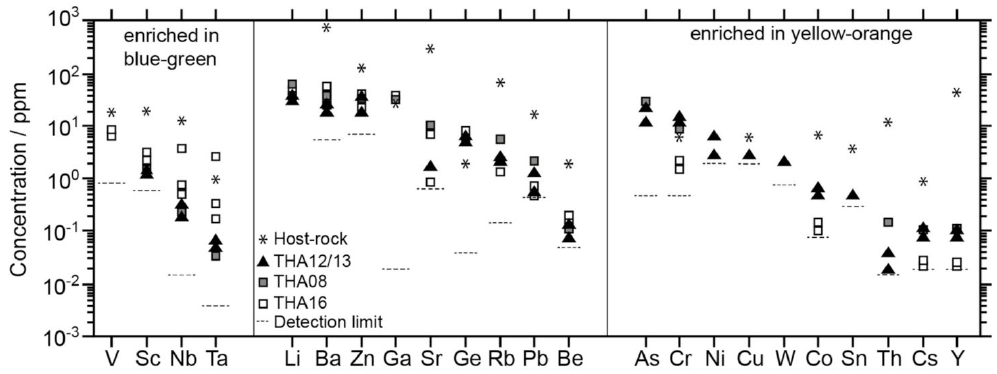
Figure 10. Trace element composition of host-rock CS16_292b and kyanite samples ordered by decreasing concentration. The left part shows elements which are preferentially found in blue-green THA16 kyanite samples, the central part where there is no significant di ff erence among the samples and the right part reports the elements with significant enrichment in yellow THA08 and orange THA12 / 13 kyanite